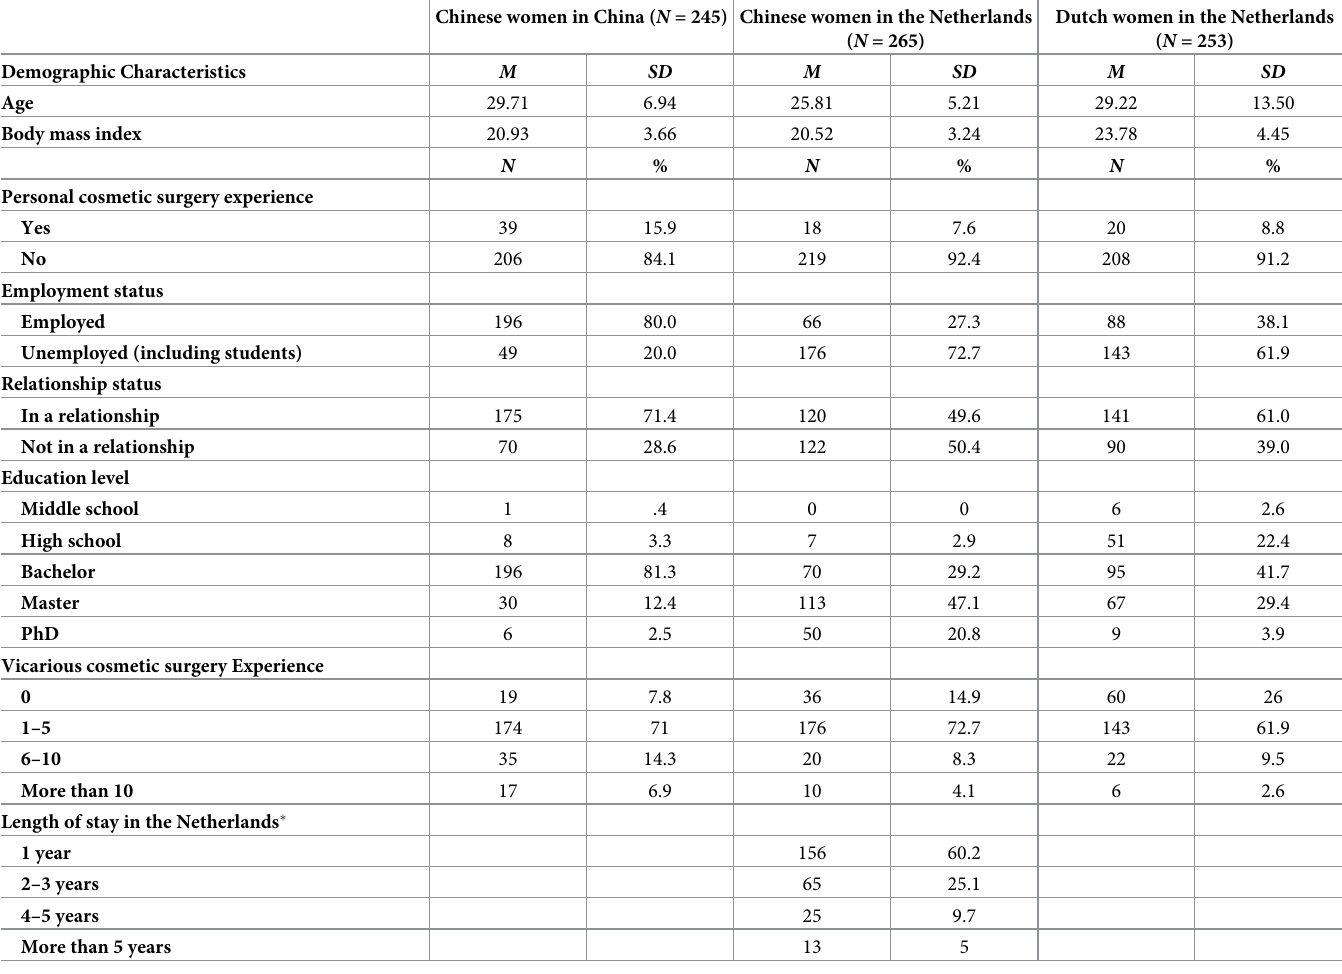
Table 1. Demographic